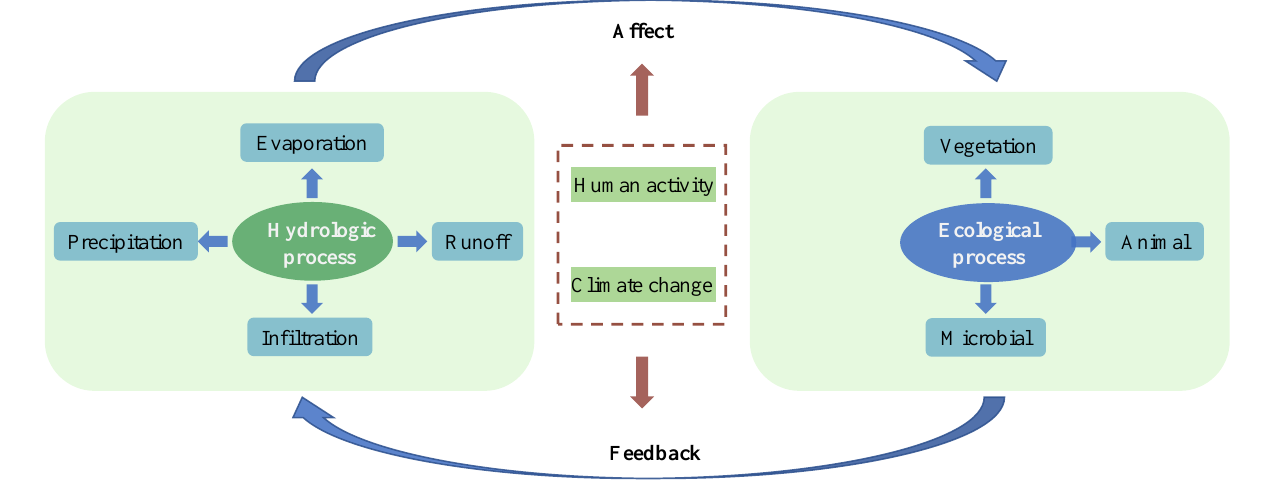
Figure 2. The interactions and feedback between hydrologic processes and ecosystem processes.